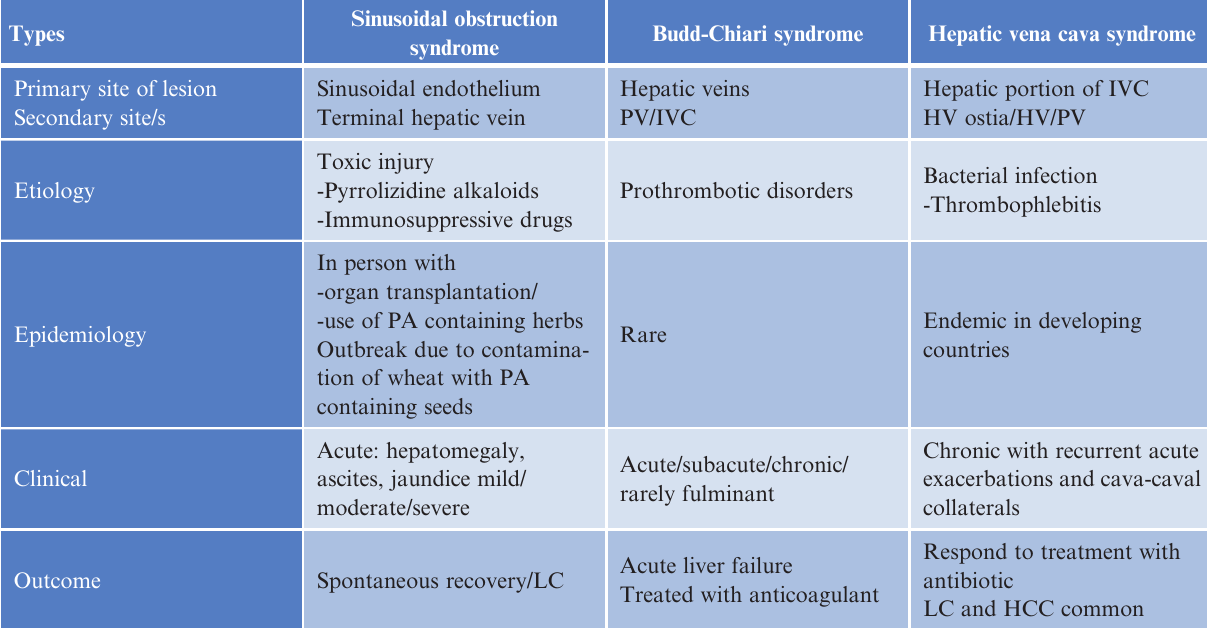
Table 1. Three primary diseases of hepatic venous out fl ow obstruction.